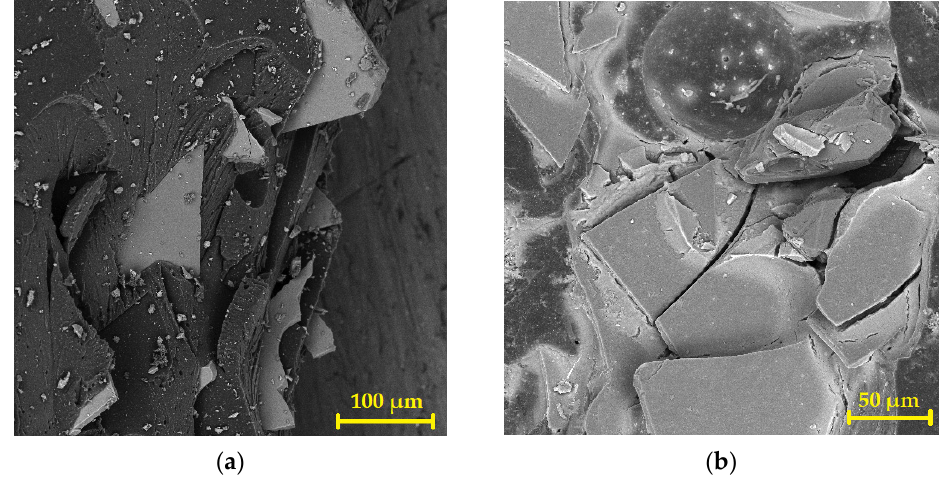
Figure 16. SEM photomicrographs of the coating NBR-GF containing glass flakes: ( a ) sample not exposed to the aggressive environment—300× magnification; ( b ) sample after exposure to 30% CH 2 O 2 for 90 days—500× magnification.